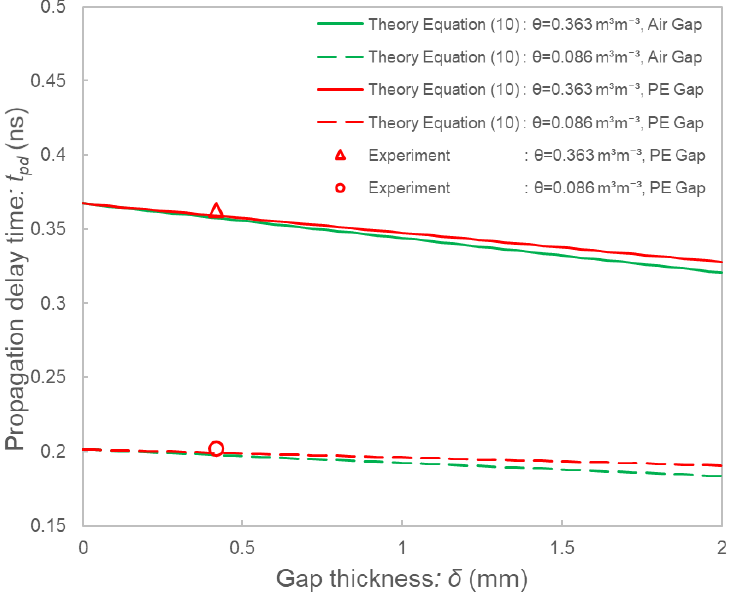
Figure 8. Comparison of the theoretical gaps models (lines) and experimental values (marks) of the SFDT sensor. The calculation values of the theoretical models of the polyethylene (PE) tapes are shown as red lines. The row data of 𝑡 𝑤 are plotted as experimental values (circle and triangle 𝑔𝑎𝑝 marks). The theoretical models of the air gap are also drawn for reference (green lines).